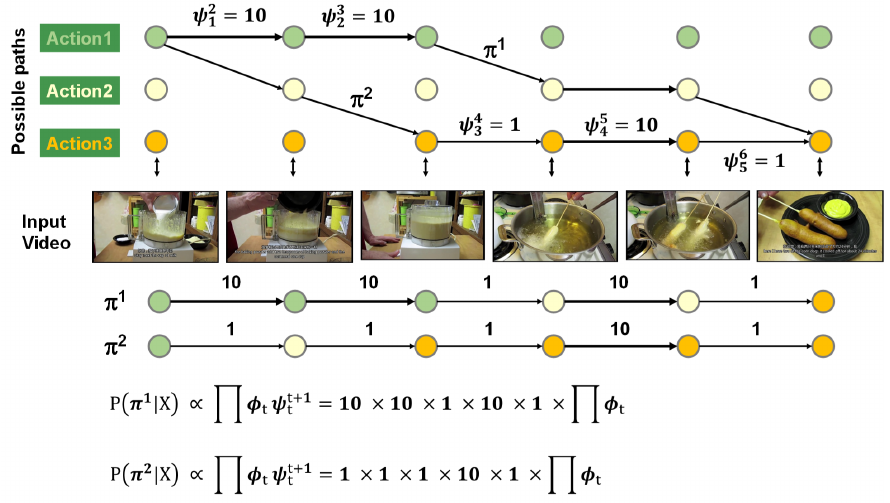
Figure 6. For illustration, an input with T = 6 frames and |A| = 3 annotated actions. High similarity is indicated by thick lines between frames. Note that π 1 stays at the same action prediction across similar frames. Consequently, Equation (6) weights π 1 higher over π 2 . In contrast, π 1 and π 2 are equally treated in original